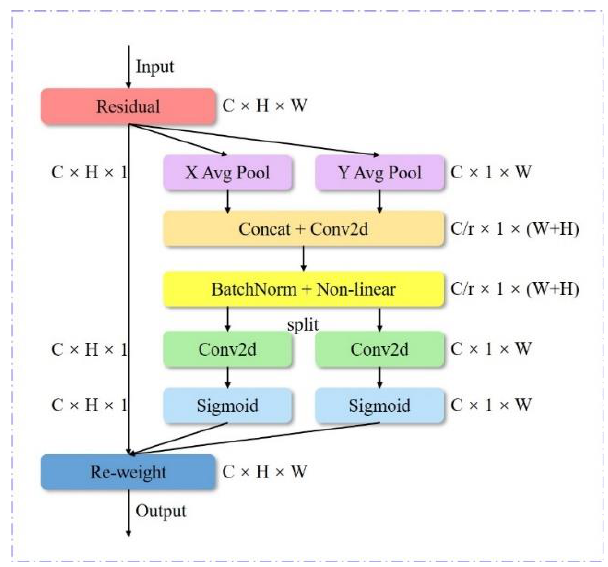
Figure 4. Structure of CA mechanism.